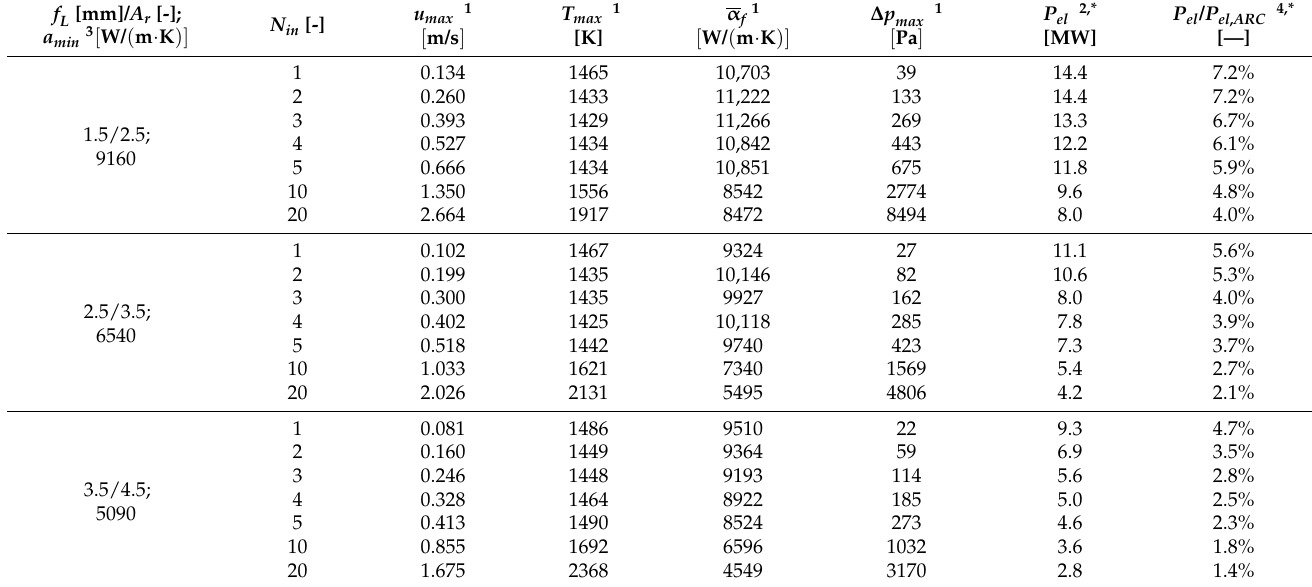
Table 8. Estimated electrical power consumption with increasing PEXS pressure